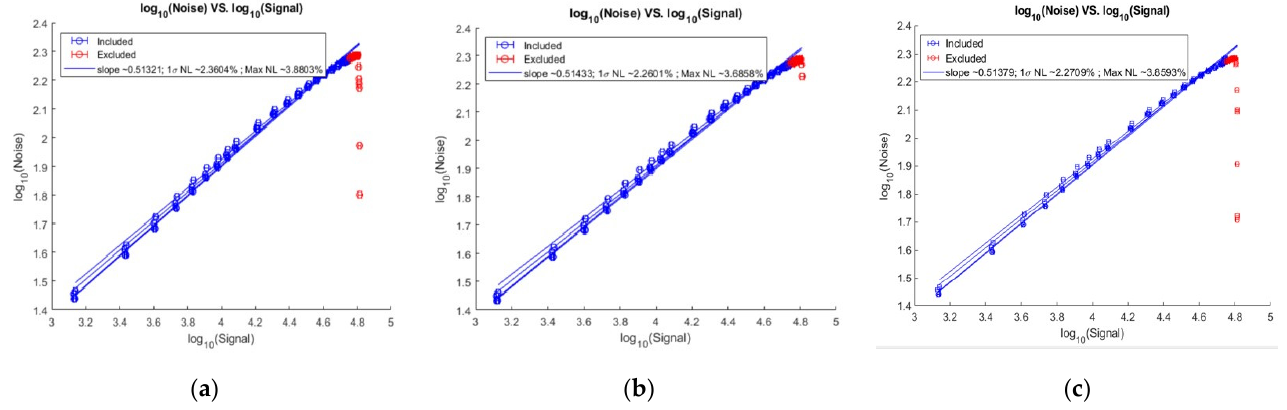
Figure 18. The PTC test result of the camera. ( a ) 28 June 2022 test result; ( b ) 6 July 2022 test result; ( c ) 19 July 2022 test result.